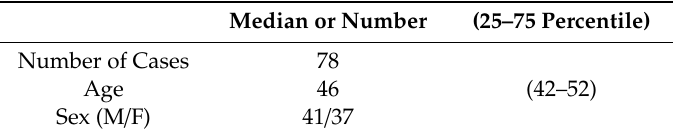
Table 3. Characteristics of the healthy